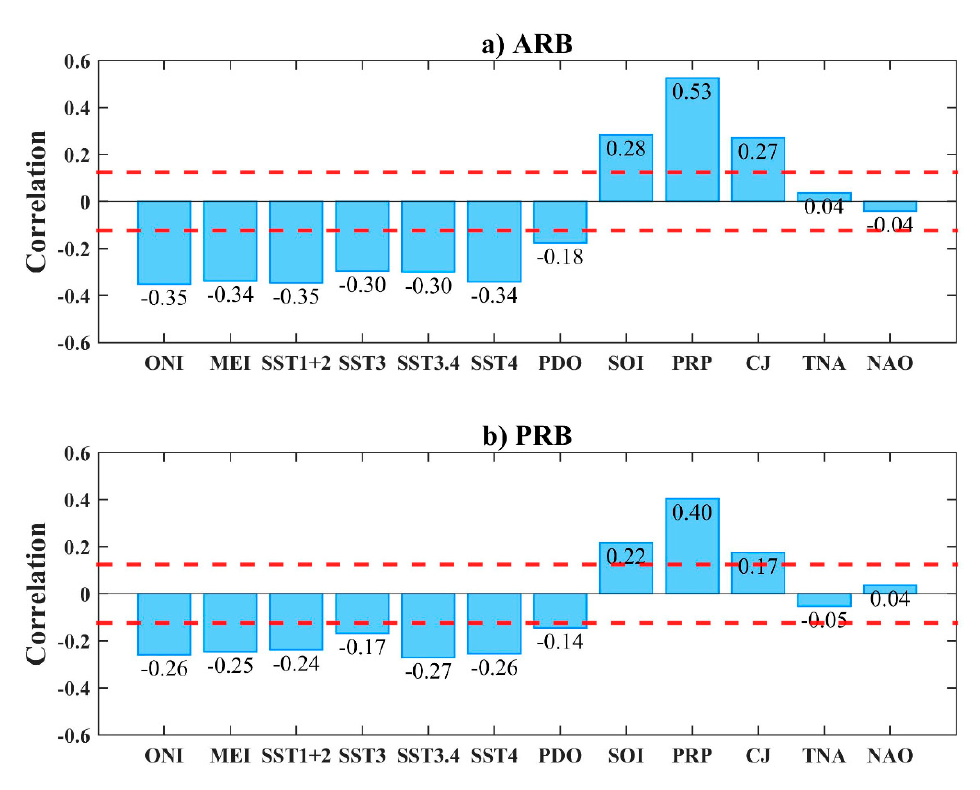
Figure 4. Tau-Kendall’s correlation between the monthly PC1 and climate indices: ( a ) ARB and ( b ) PRB. The dashed lines indicate a significance level of 0.05. Table 4. Kendall’s correlation between the annual, maximum, and minimum PC1s and climate indices. Statistically significant correlations at the 5% significance level are show in bold. PC1